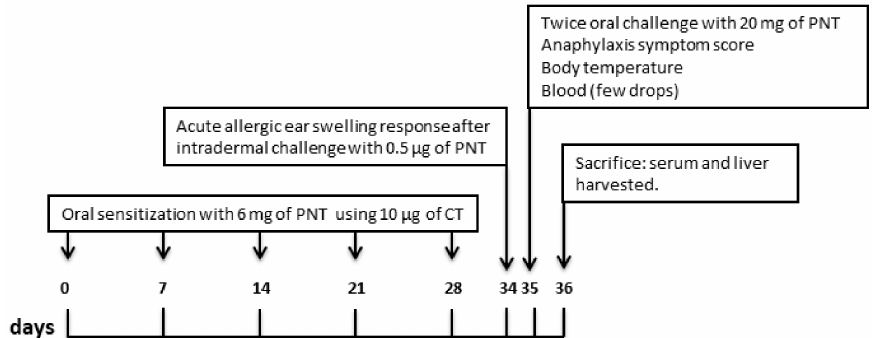
Figure 1. Schematic overview of the experimental design. Three-week-old female C3H/HeOuJ mice ( n = 6 per group) were sensitized orally every 7 days for 4 weeks using a blunt needle with peanut extract (PNT) + cholera toxin (CT) as adjuvant. Controls mice receive CT only. On day 34, mice received intradermal injection of PNT in the ear pinnae acute allergic skin response was measured. After 24 h, mice were challenged by gavage with PNT and anaphylaxis score and body temperature were determined. On the next day mice were sacrificed, liver and blood samples were